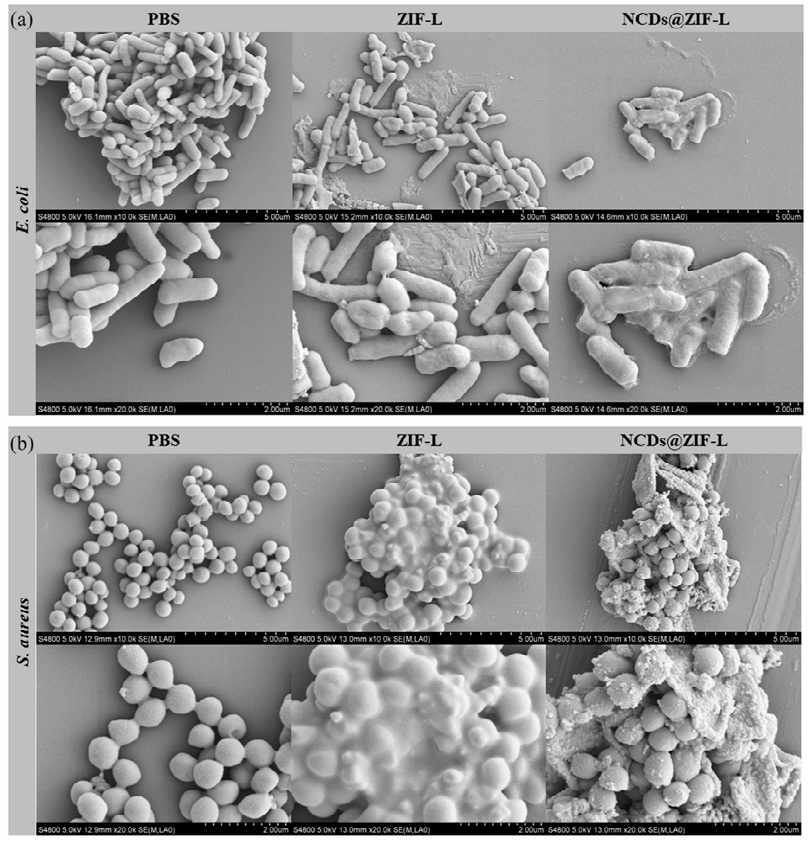
Figure 7. SEM images of E. coli ( a ) and S. aureus ( b ) after treatment with sterile PBS, ZIF-L, and NCDs@ZIF-L composites. NCDs@ZIF-L